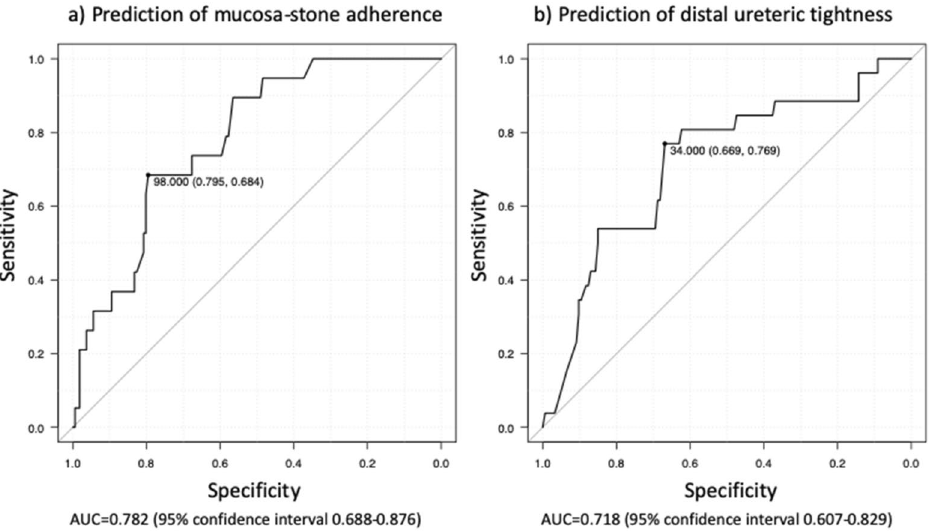
Figure 1. Receiver operating characteristic (ROC) curve of the duration until surgery for predicting mucosa- stone adherence ( a ) and distal ureteric tightness ( b